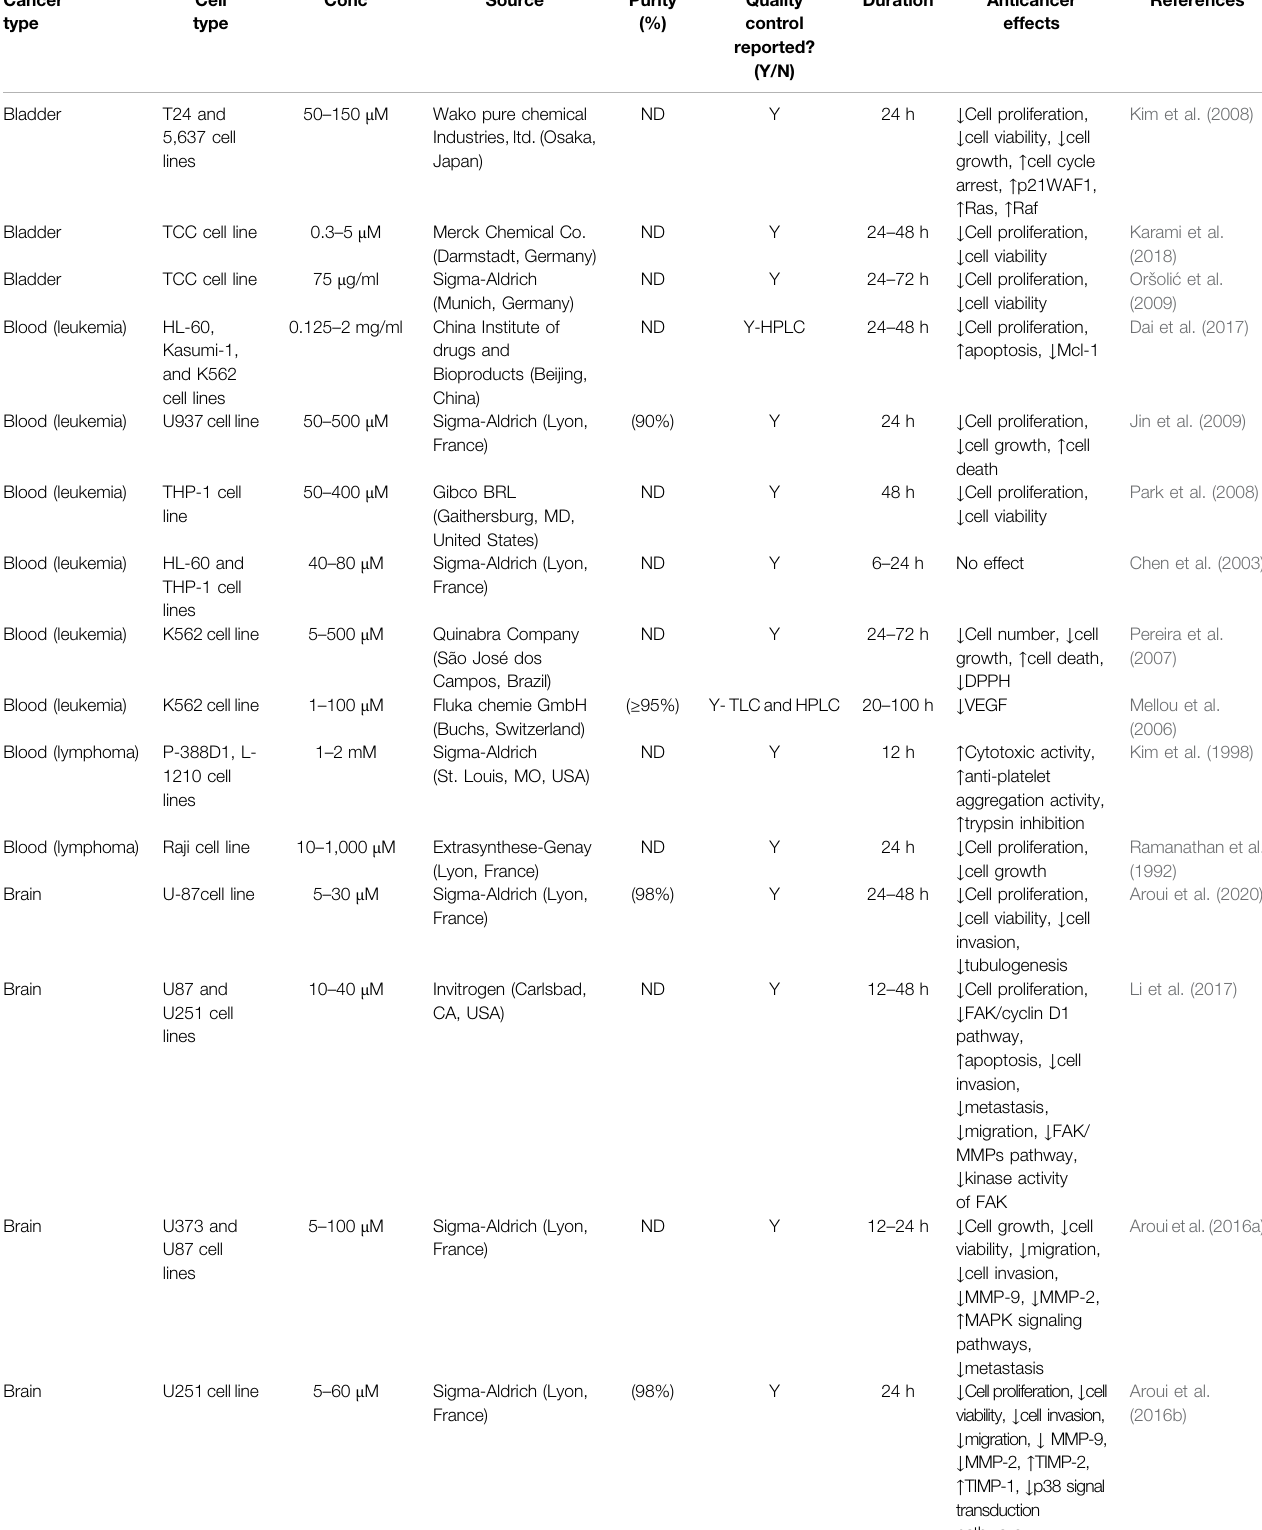
TABLE 3 | Potential anticancer effects and related mechanisms of action of naringin based on in vitro